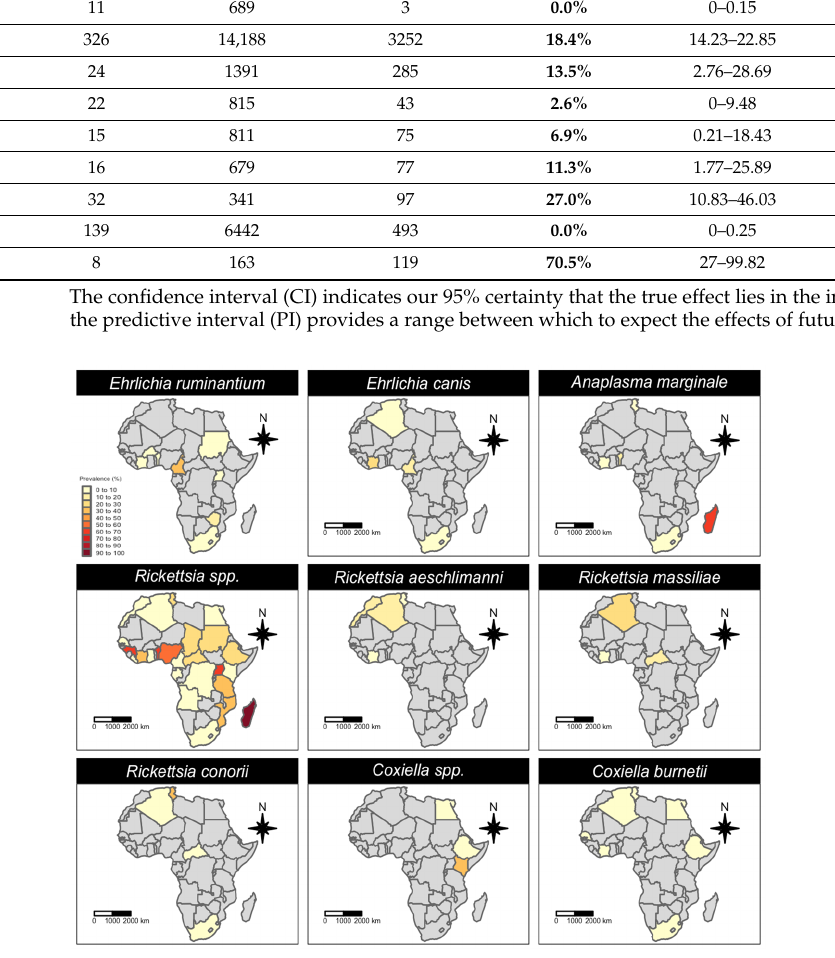
Figure 9. Choropleth maps showing the molecular prevalence of Anaplasmataceae , Rickettsiaceae and Coxiellaceae in African ticks. Only the estimates showing a significant association sampling country are here displayed. CLEs were reported only from two countries (Sao Tome and Principe and Algeria), hence their distribution is not represented here.